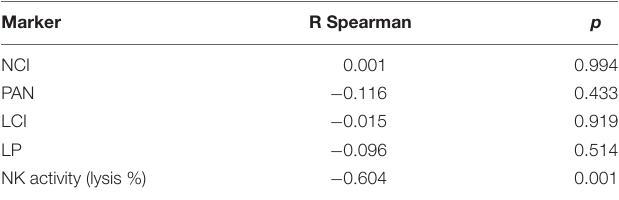
TABLE 5 | Depression and immune marker correlations.